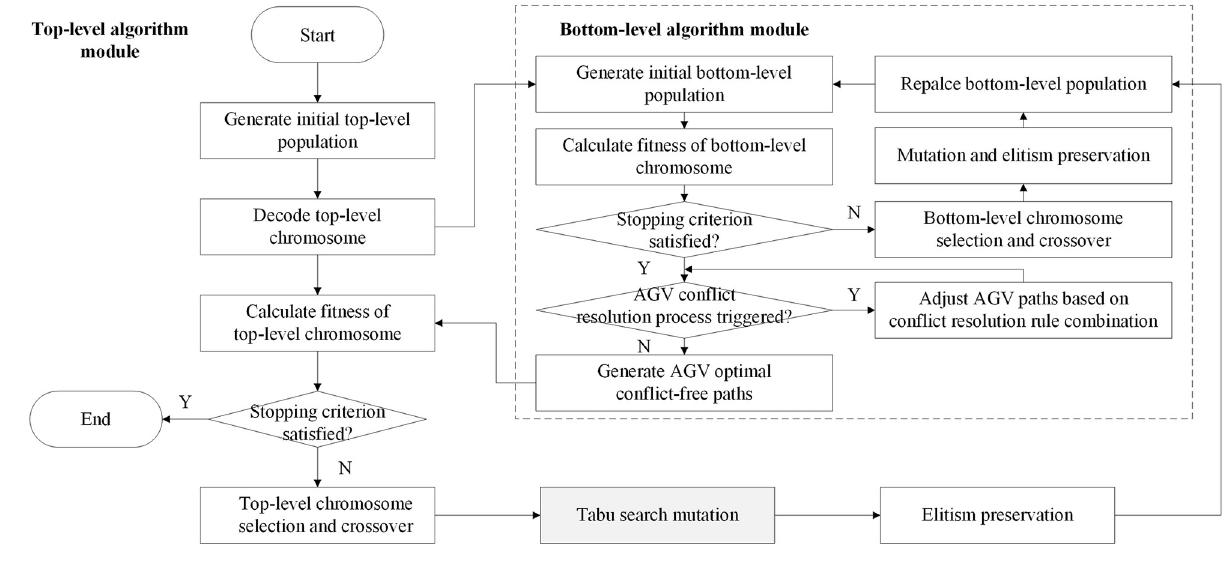
Fig 10. Flow chart of the